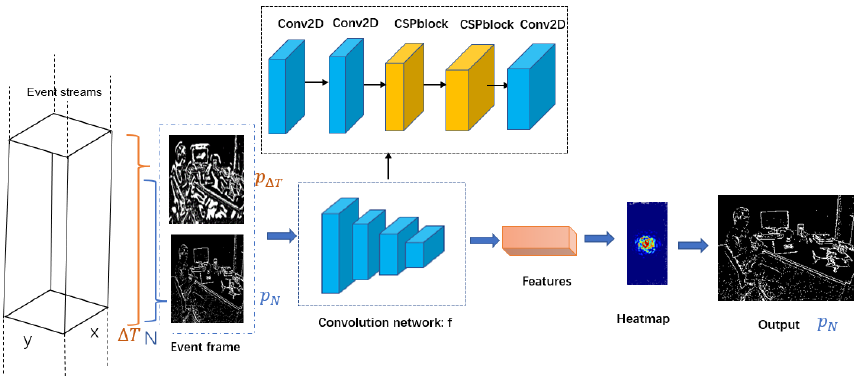
Figure 2. Overview of our reconstruction strategy of the event image, Event streams represent an event flow of asynchronous data that is updated on a time series. The event frame indicates the candidate event image. The CNN indicates a shallow convolutional neural network to extract features. By comparing features, a higher heatmap means that the quality of the features is better and a better event image can be output. In this case, P N provides higher-quality event images with better texture